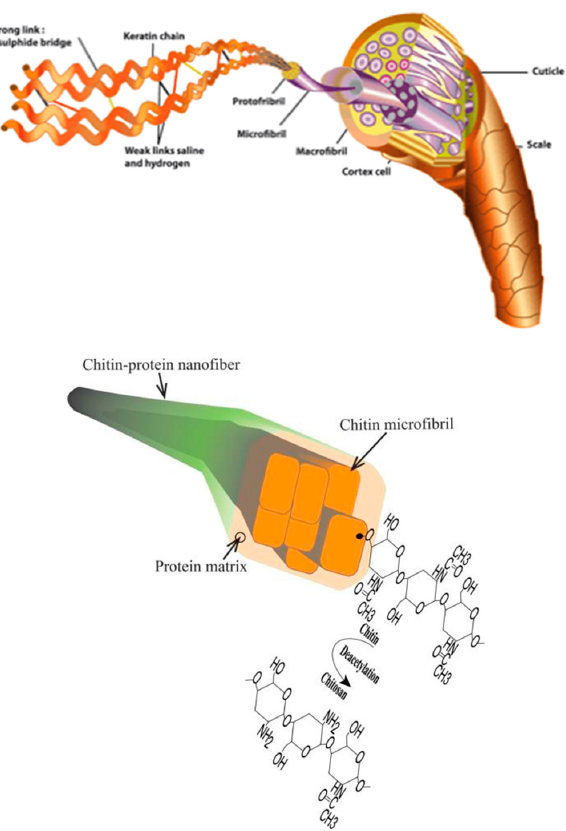
Figure 7. Chitin resembles the function of keratin in mammals [63].